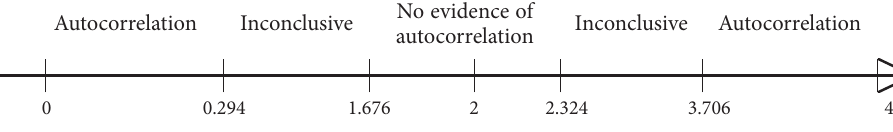
Figure 3. Interpretation of Durbin-Watson statistical values in a multiple linear regression analysis with two independent variables (source: authors) Of all the 45 models, the p -value of only two models confirmed the significance of both independent variables in the equation, but multicollinearity was found in one of them. Thus, the most accurate multiple linear regression model is in Table 4. Table 4. Coefficient of determination of a multiple linear regression equation, ANOVA p -value, and Durbin-Watson statistics (source: authors)